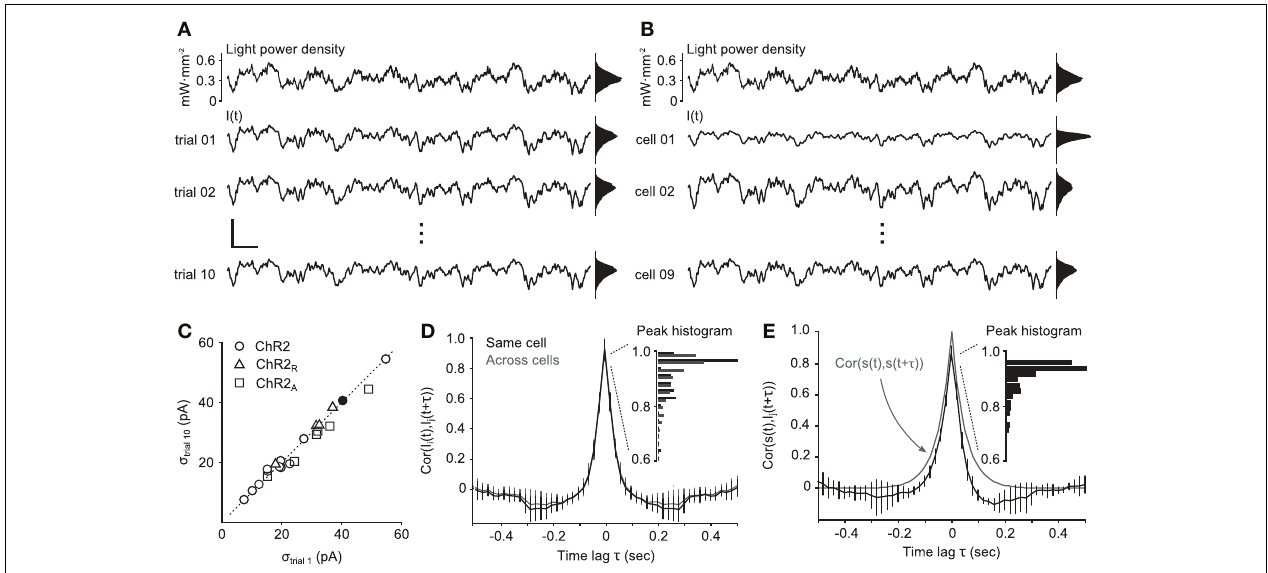
FIGURE 4 | Reliability of continuously-varying neuronal photostimulation. (A) Intracellular currents from a single cell during Gaussian stimuli. The top trace is a portion of a 10-s Gaussian stimulus sequence. The bottom three traces show the intracellular currents recorded during different presentations of the same stimulus waveform. Scale bars, 200pA and 200ms. Scale bars apply to all time series traces in the figure. (B) The same stimulus waveform used in (A) , and the corresponding evoked responses from different cells. (C) The standard deviation of the photocurrent induced on the first trial of stimulation versus on the last trial. The dotted line is identity. Points near the